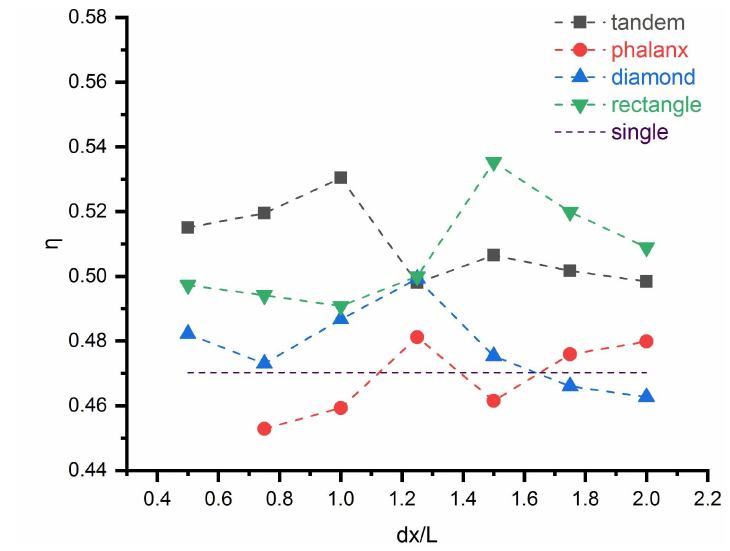
Figure 21. The average Froude